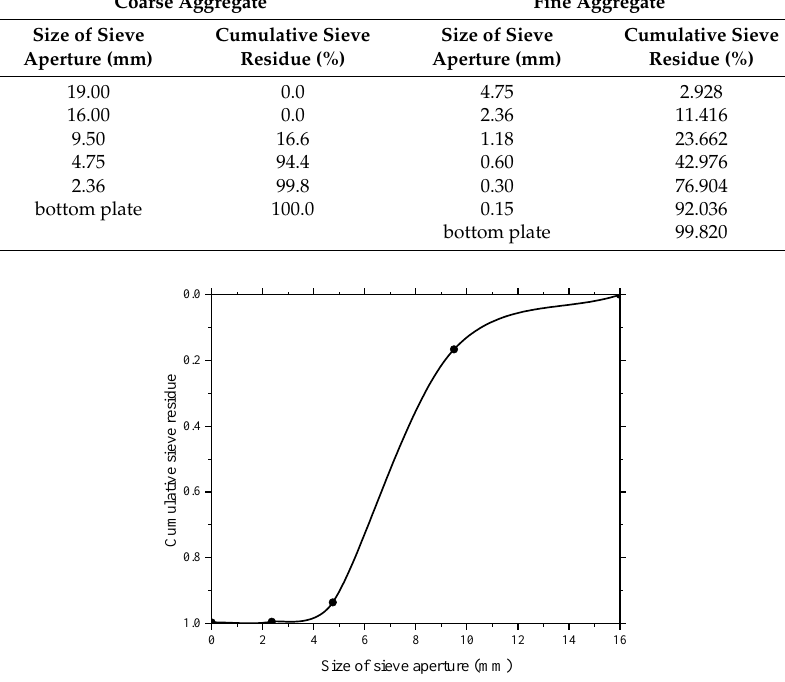
Figure 4. Sieve curve of coarse aggregate.